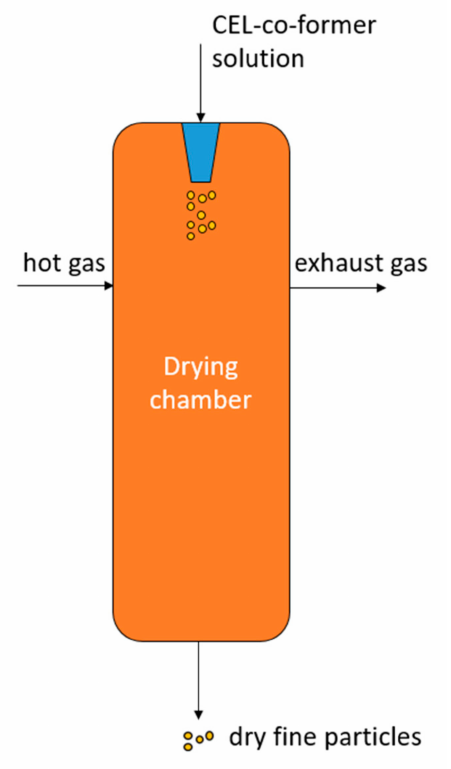
Figure 1. Schematic illustration of the spray drying process.